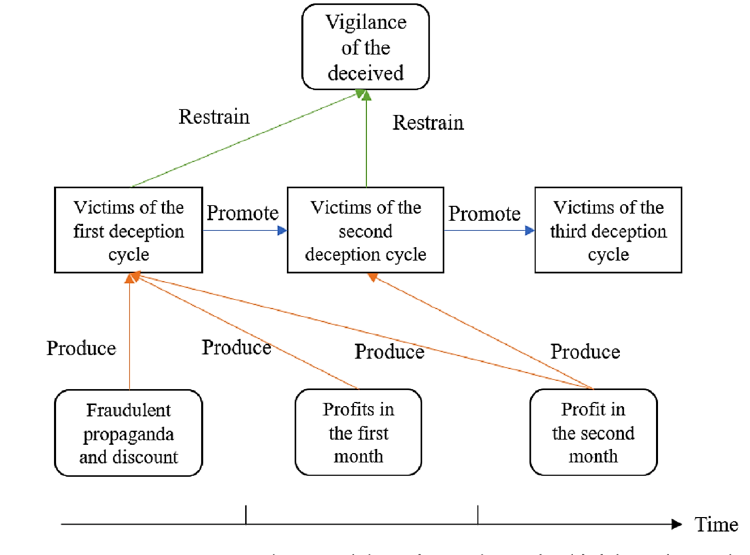
Figure 2. The capital flow of the fraud.